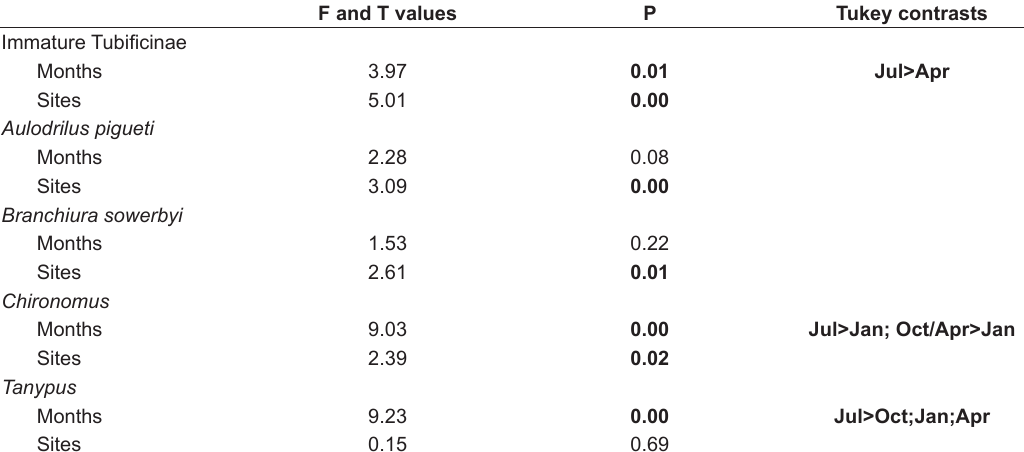
Table 3. Differences in densities of some Oligochaeta and Chironomidae taxa determined by ANOVA (F and p) and Student t-test (T and p) in October 2013, January, April and July 2014 in the Guareí River (R) and the lateral area (L) and contrasts by Tukey test (significant differences in